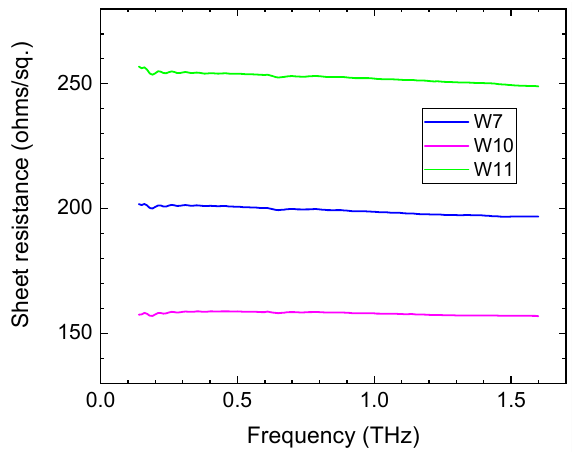
Figure 8. Examples of frequency-resolved sheet resistance measured in three wafers.